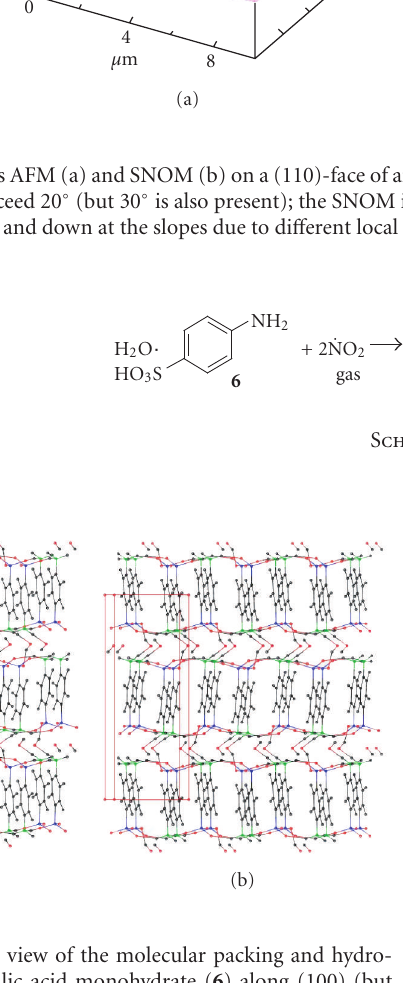
Figure 5: Stereoscopic view of the molecular packing and hydro- gen bonding of sulfanilic acid monohydrate ( 6 ) along (100) (but rotated around y by 10 ◦ for a better view) with (010) on top show- ing hydrogen-bridged strings of molecules that can only be chemi- cally attacked from the sides; the (010)-surface will have all accessi- ble amino groups (any other molecule)